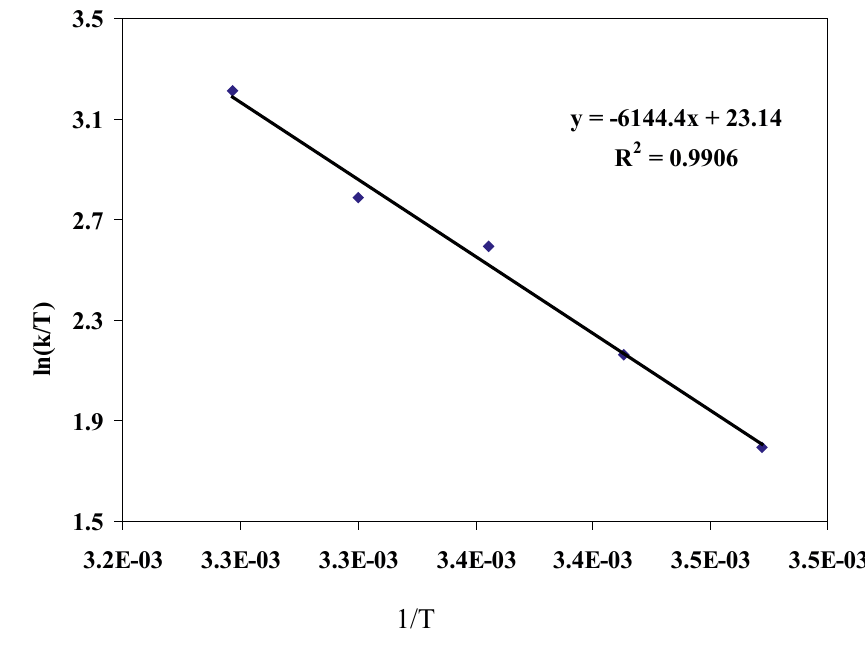
y = -6144.4x + 23.14 R 2 = 0.9906